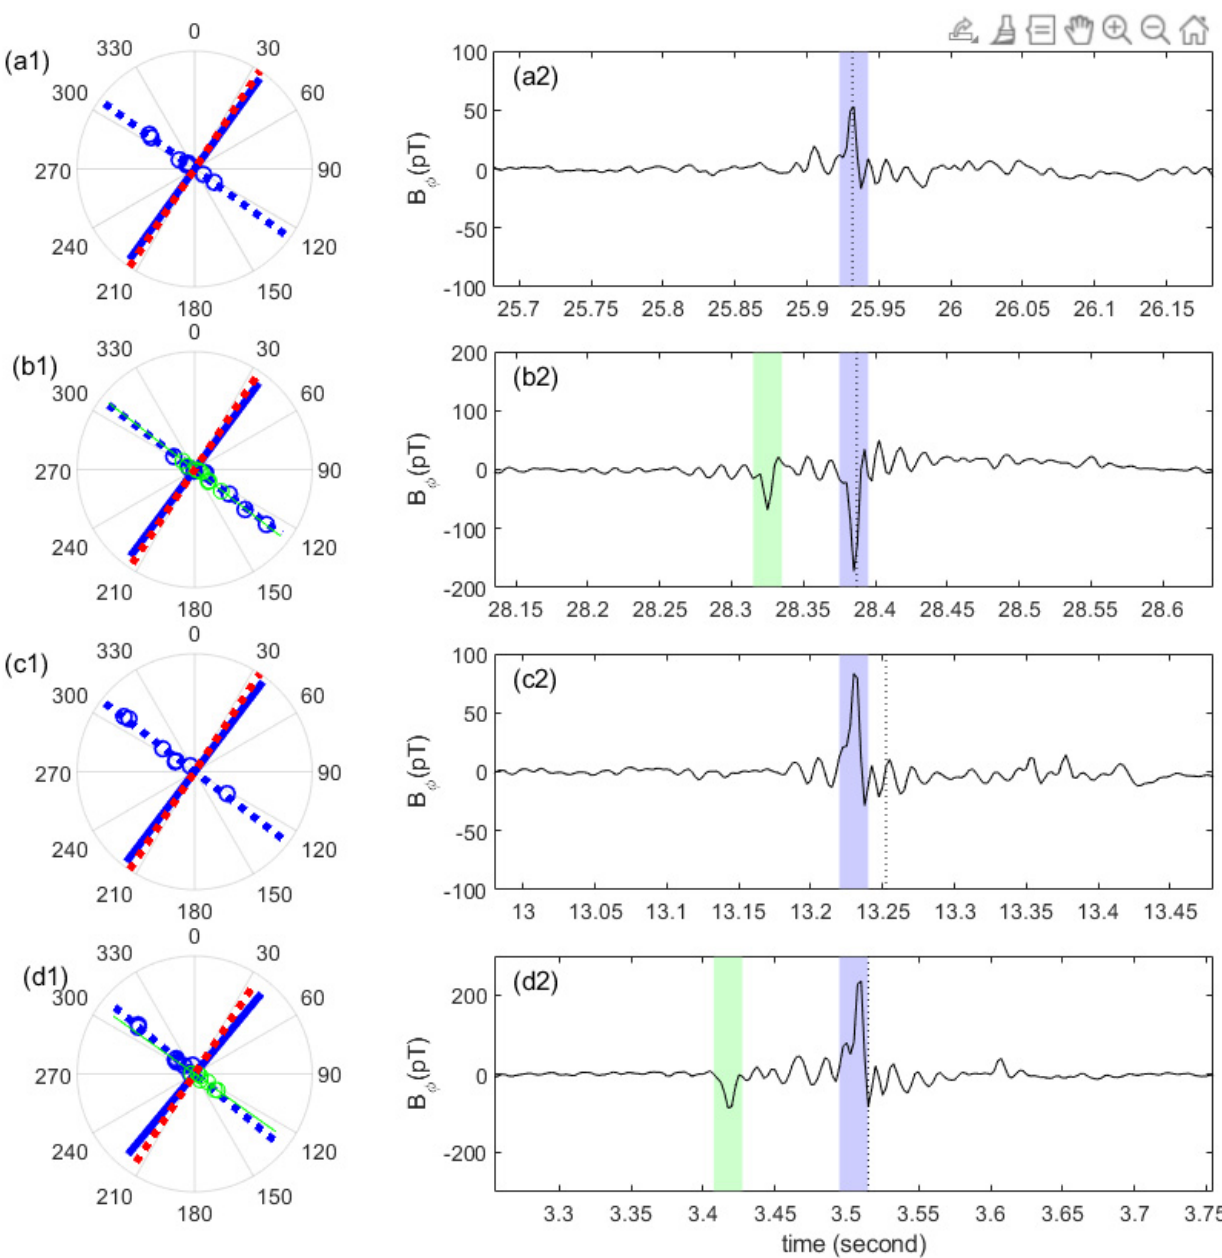
Figure 11. We analyzed the recorded ELF signals provided by the magnetometer station at the Kuju station (33.059 ◦ N, 131.233 ◦ E) in Japan for parent lightning of elves at GPS time ( a1 , a2 ) 13:07:25.9316, ( b1 , b2 ) 13:56:28.3870, ( c1 , c2 ) 15:00:13.2524 and ( d1 , d2 ) 16:24:03.5149 (UT) on 22 June 2020. In the left panels ( a1 , b1 , c1 , d1 ), Lissajour Plots show their data points from NS (North-South) and EW (East-West) directions and the wave oscillation plane (blue dashed line). Perpendicular to the wave oscillation plane, the wave propagation direction (solid blue line) traced the generated wave source compared to the direction (red dashed lines) from the Kuju station to the WWLLN determined geometric locations. In the right panels ( a2 , b2 , c2 , d2 ), we plot the ф- component of the ELF waveform from lightning source to the ELF recorded station after the transformation of recorded ELF signals from the North-South/East-West direction to the azimuthal ( ф )-direction. Using the B ф in pico-tesla (pT) units, we can estimate the charge-moment-change associated with lightning. The data points (blue and green circles) in the left panel (Lissajour plot) show the wave direction and assure the uniqueness of ELF wave sources, which are also corresponding to the ELF data in the right panel with blue and green filled region, respectively. Vertical black dashed lines indicate their GPS times in Table 1.